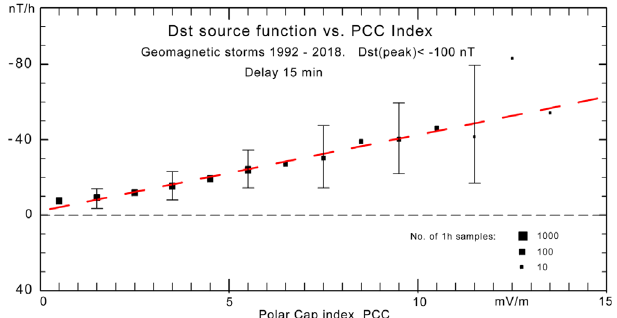
Fig. 12. Scatter plot of d(Dst*)/d t corrected for decay vs. polar cap PCC index. The black squares represent bin-average values and no of hourly samples while the error bars in every other bin represent standard deviation among